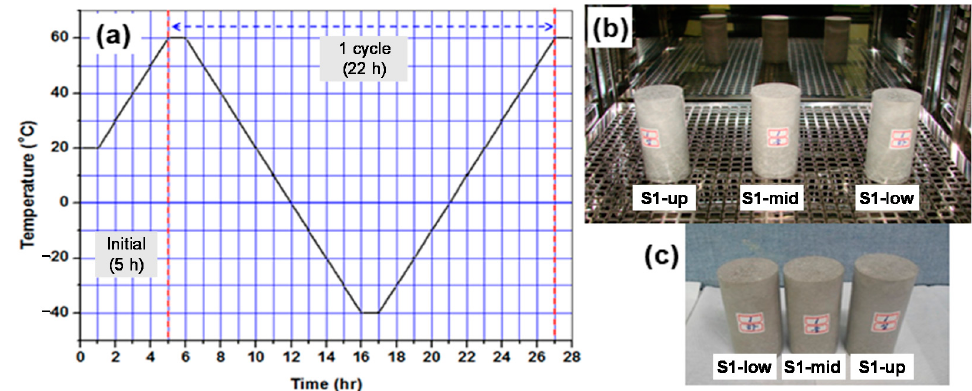
Figure 5. ( a ) Illustration of temperature changes during a single cycle ( b ) Image of the samples subjected to the test ( c ) Image of the samples after the test.